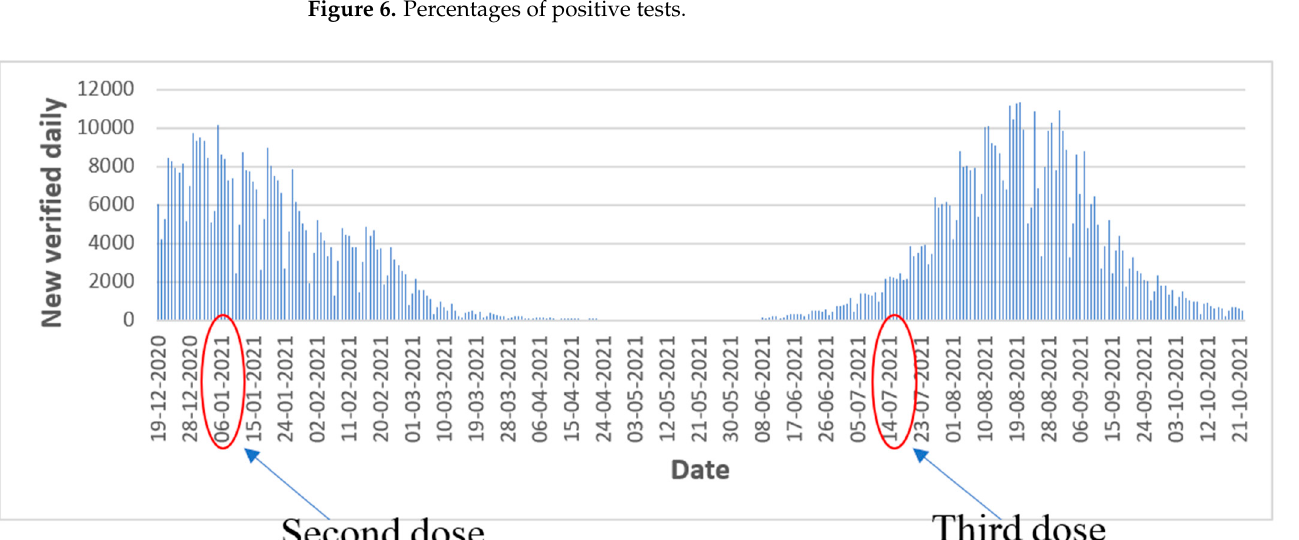
Figure 6. Percentages of positive tests.